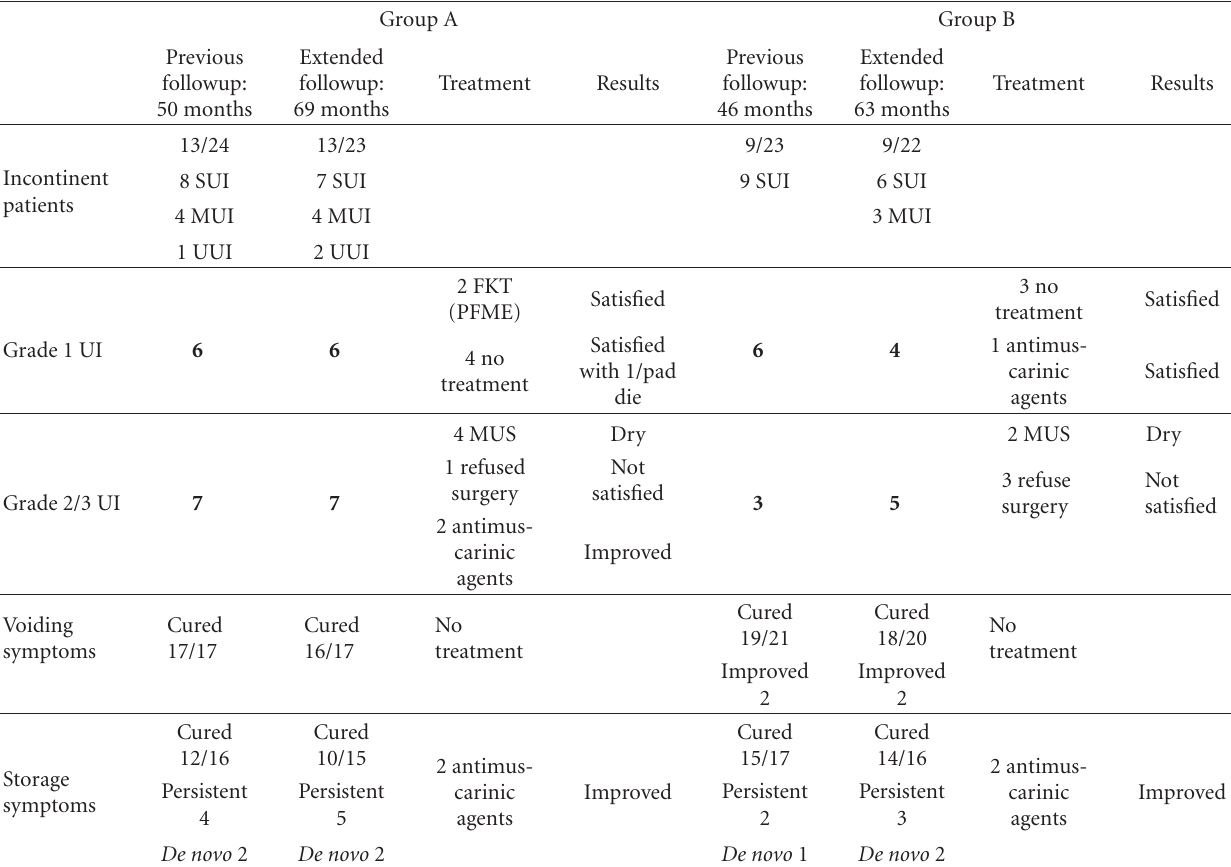
Table 2: Incontinence, voiding, and storage symptoms: long-term followup in groups A and B. Mid- and long-term